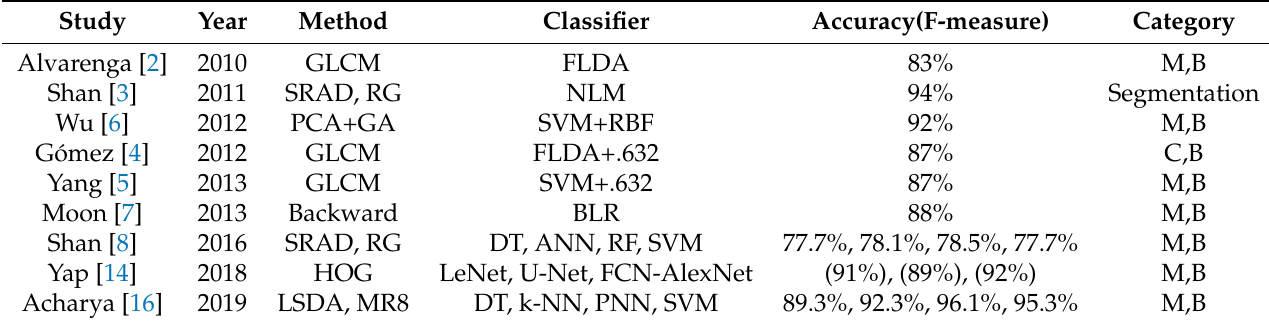
Table 3. Literature reviews of breast ultrasound CAD